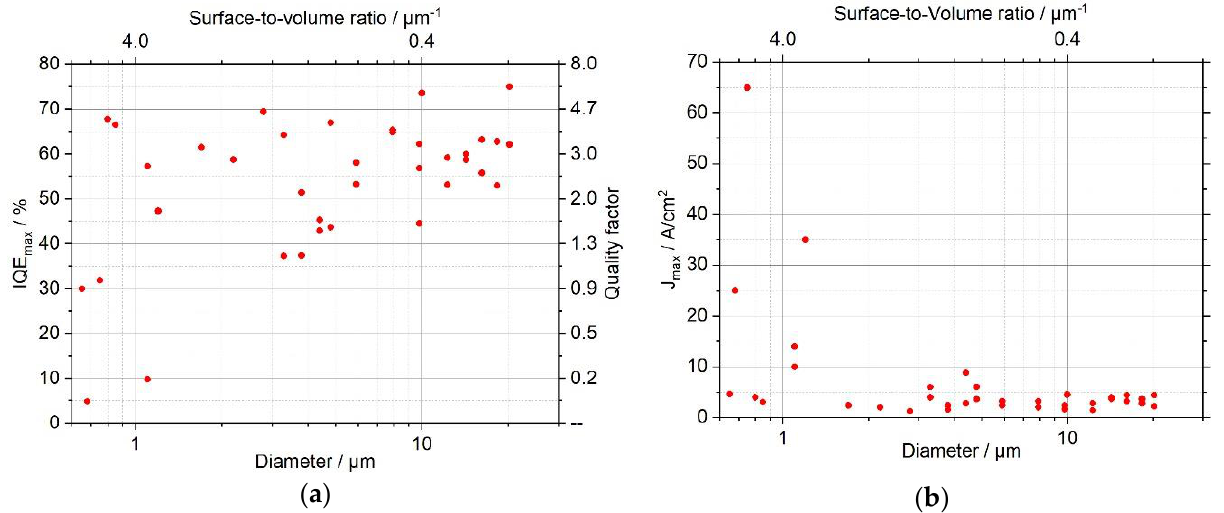
Figure 4. Size-dependent ( a ) maximum internal quantum efficiency IQE max and ( b ) current density at the maximum internal quantum efficiency J max derived from the EL spectra by using the ABC model. With decreasing µ LED diameter, IQE max and quality factor Q decrease, while J max increases.